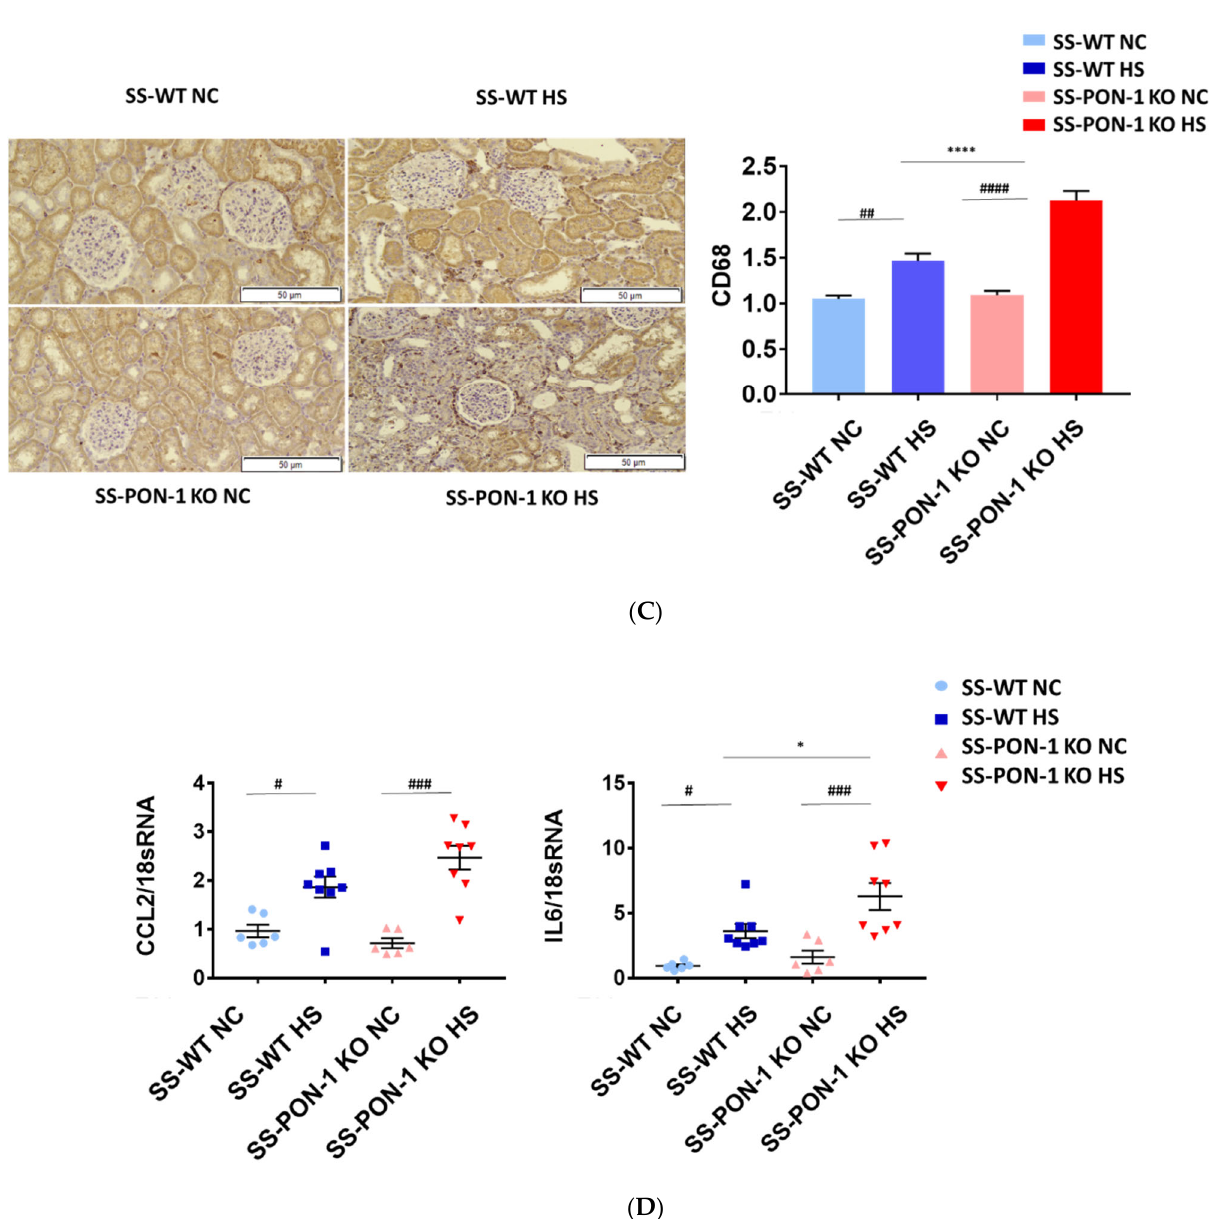
Figure 4. Targeted mutation of paraoxonases ‐ 1 contributes to an increase in renal oxidative stress as demonstrated by ( A ) 8 ‐ Oxo ‐ 2 ′‐ deoxyguanosine (8 ‐ OHdG) histology, ( B ) urinary excretion of 8 ‐ OHdG, ( C ) recruitment of CD68 positive immune cell in renal interstitium, and ( D ) increased expression of key inflammatory gene in renal cortical tissue. SS ‐ PON ‐ 1 KO rats show significant increase in renal inflammatory markers, compared to SS rats following 5 weeks 8% high ‐ salt diet (HS N = 8, NC N = 6). * p < 0.05, **** p < 0.0001 vs. high ‐ salt, # p < 0.05, ## p < 0.01, ### p < 0.001, #### p < 0.0001 vs. normal chow.